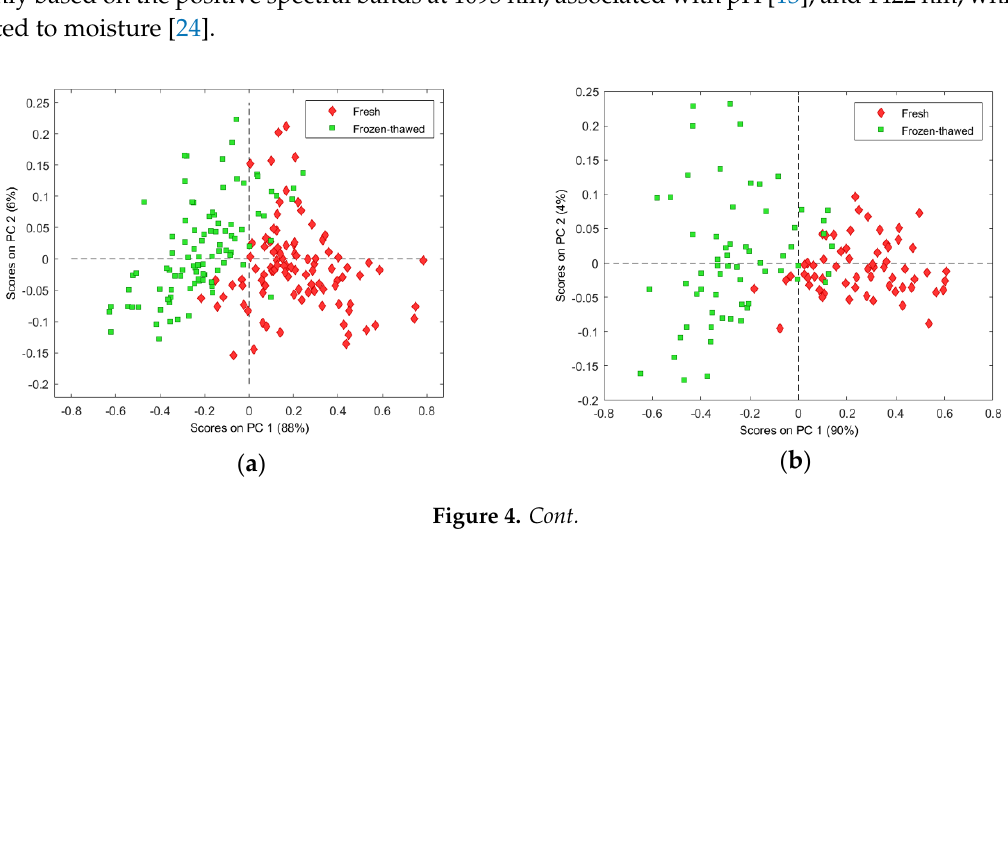
Figure 3. Standard normal variate (SNV) pre-processed mean spectra for fresh ( red ) and frozen–thawed ( green ) zebra, springbok, and ostrich.